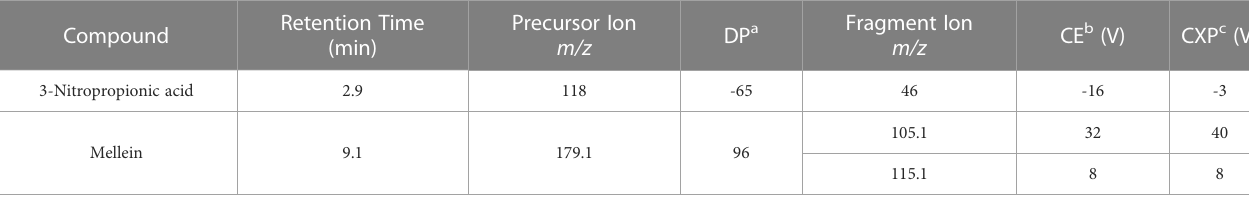
TABLE 2 Optimized LC-MS/MS parameters for mellein and 3-nitropropionic acid.